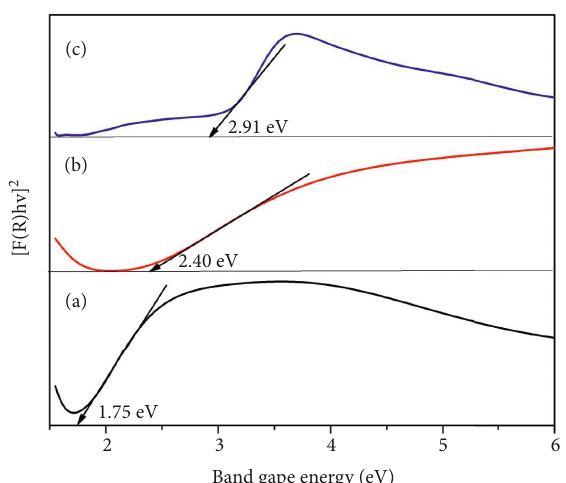
Figure 4: DRS patterns of (a) NiFe 2 O 4 , (b) NiFe 2 O 4 @TiO 2 , and (c) NiFe 2 O 4 @TiO 2 @rGO core@shell nanoparticles.